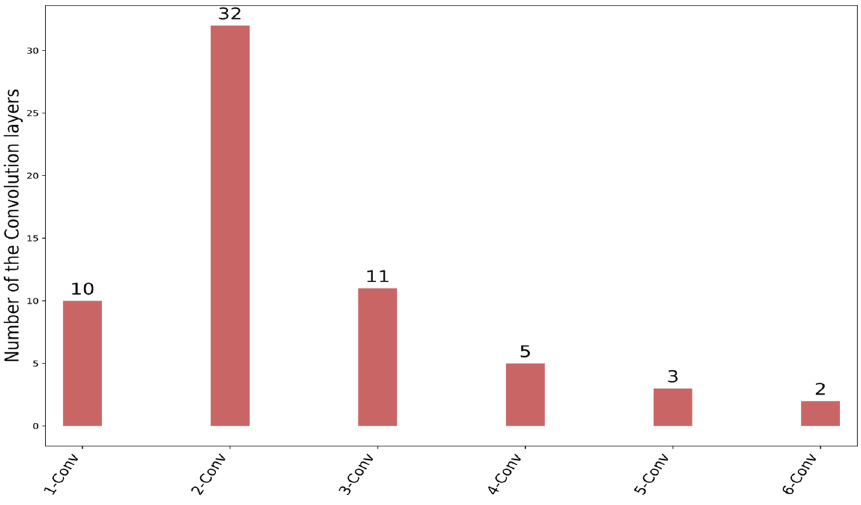
Figure 8. Number of convolutional layers that have been used for IDS schemes.